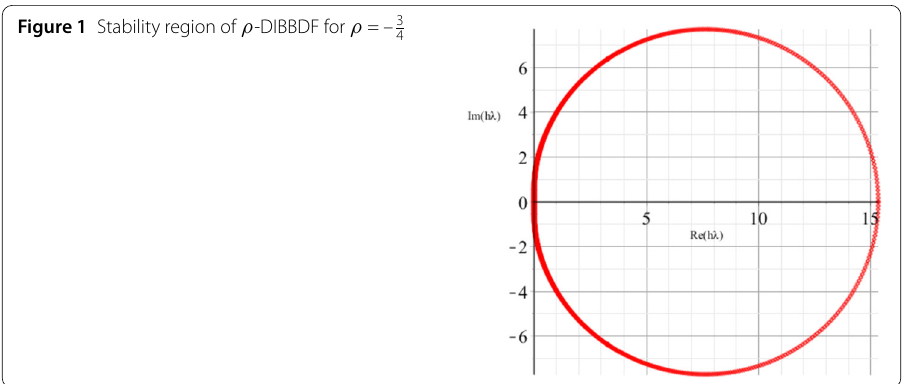
Figure 1 Stability region of ρ -DIBBDF for ρ = – 3